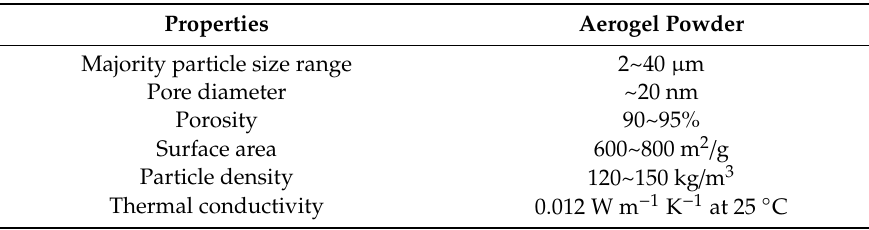
Table 1. Specifications of aerogel particles used in the